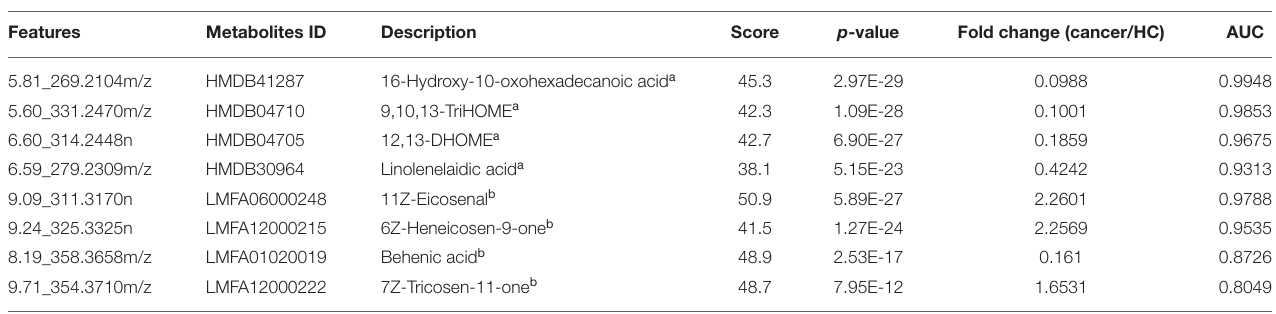
TABLE 2 | Differential metabolites for distinction of cancer (BC and RCC) and control.